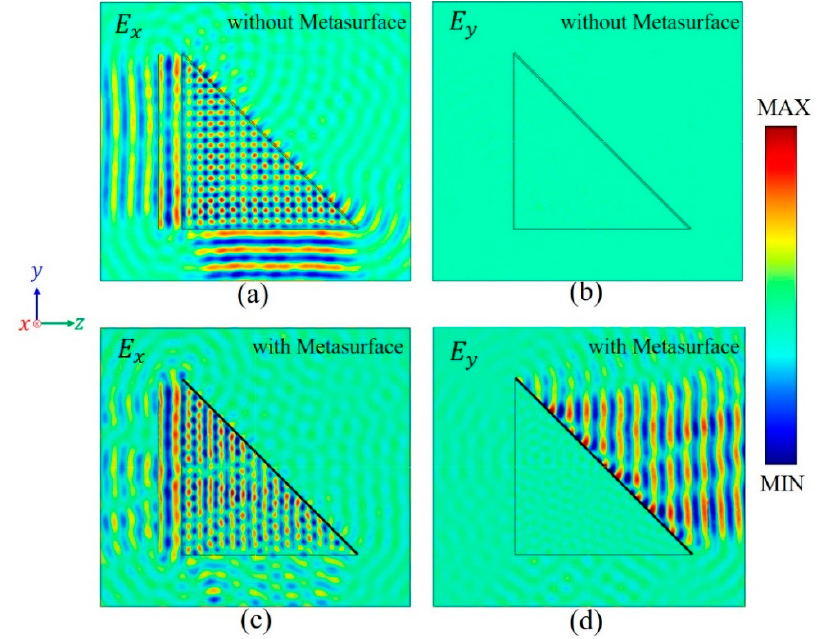
Figure 3. Simulated THz wave propagation controlled by a prism ( a , b ) Without and ( c , d ) With a metasurface attached.